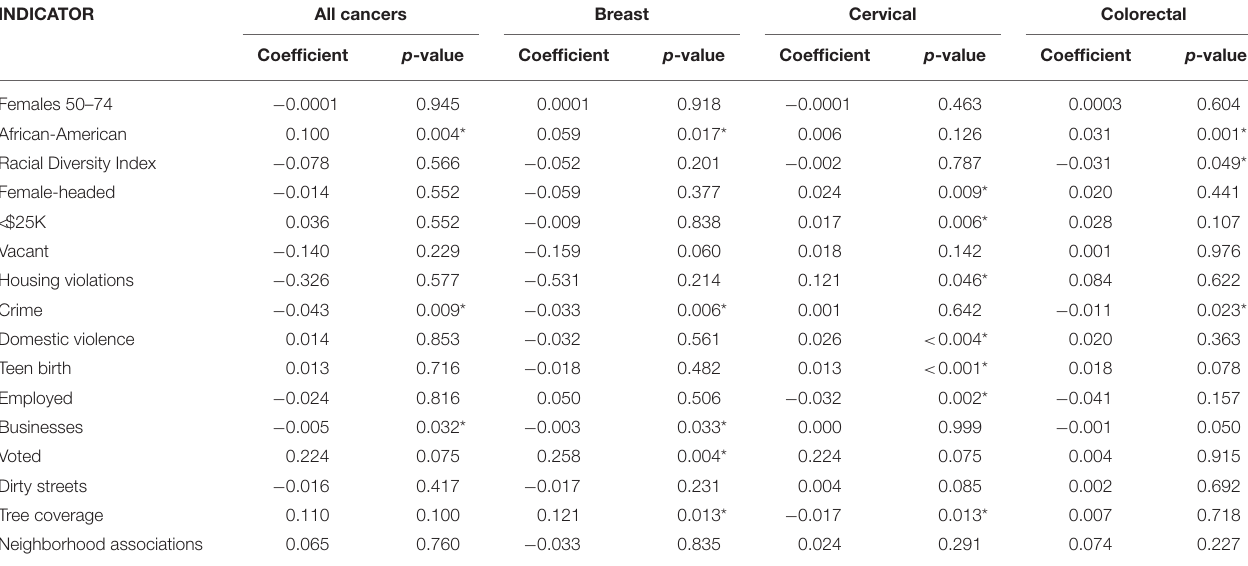
Table 3A | Unadjusted ordinary least squares regression models for female cancer incidence by cancer site and neighborhood-level covariates, Baltimore City, 2000–2010.